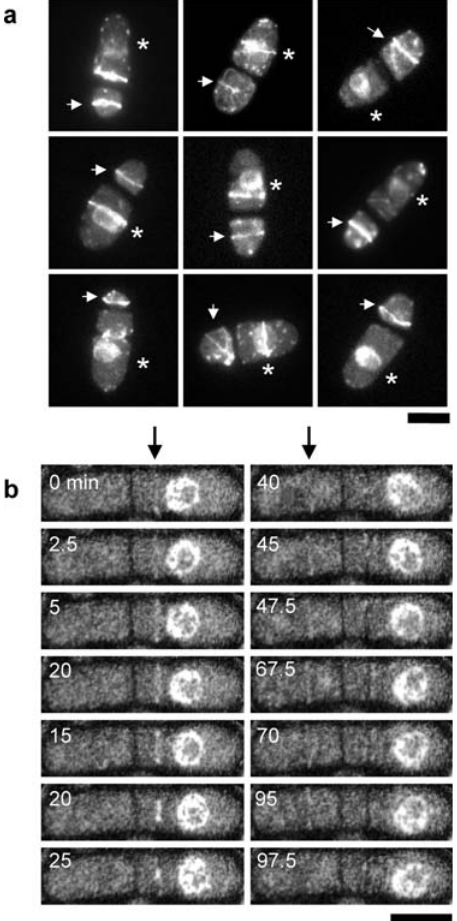
Figure 4. Assembly of cell division structures in anucleate cells. (a) F- actin ring assembly. Shown is a collage of fixed cdc16 -116 cells expressing the nuclear membrane marker Uch2p-GFP stained with the F-actin specific dye Alexa 488-phalloidin. F-actin rings/cables present in the anucleate compartments are indicated with arrows, while asterisks identify the nucleate compartments. Scale, 10 m m. (b) Actomyosin rings in anucleate cells are unstable and do not constrict. Shown is a time- lapse montage of a live cdc16 -116 cell expressing the nuclear membrane marker Uch2p-GFP and the actomyosin ring marker Rlc1p- GFP. The connected but distinct cells have a nucleate half and an anucleate half. During time point 0 min to 25 min, a newly formed actomyosin ring was organized in the nucleate cell (arrow, 0 min). This ring underwent complete constriction within , 30 min. In contrast, although the anucleate cell organized an actomyosin ring (arrow, 40 min), this ring failed to undergo constriction during , 60 min of observation. Scale, 5 m